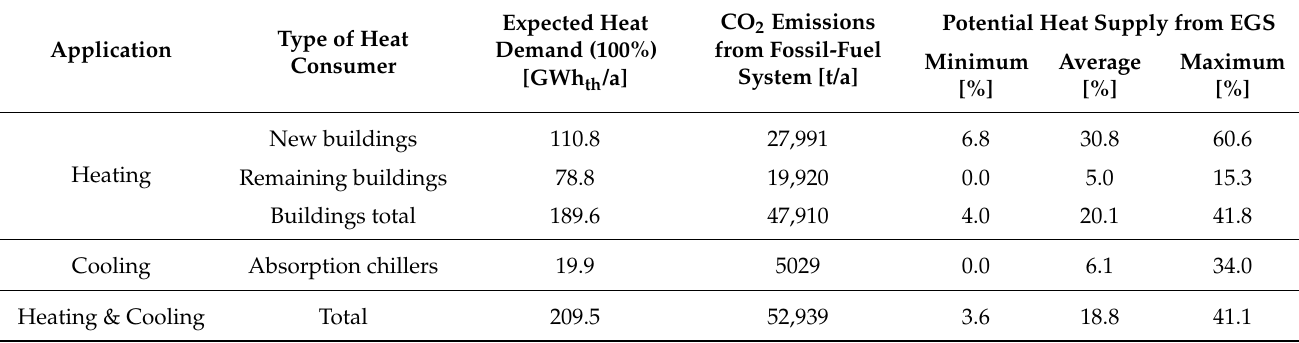
Table 4. Lifetime-average potential heat supply from EGS as a share of heat demand of different consumers and CO 2 emissions of a future fossil-fuel based heating and cooling